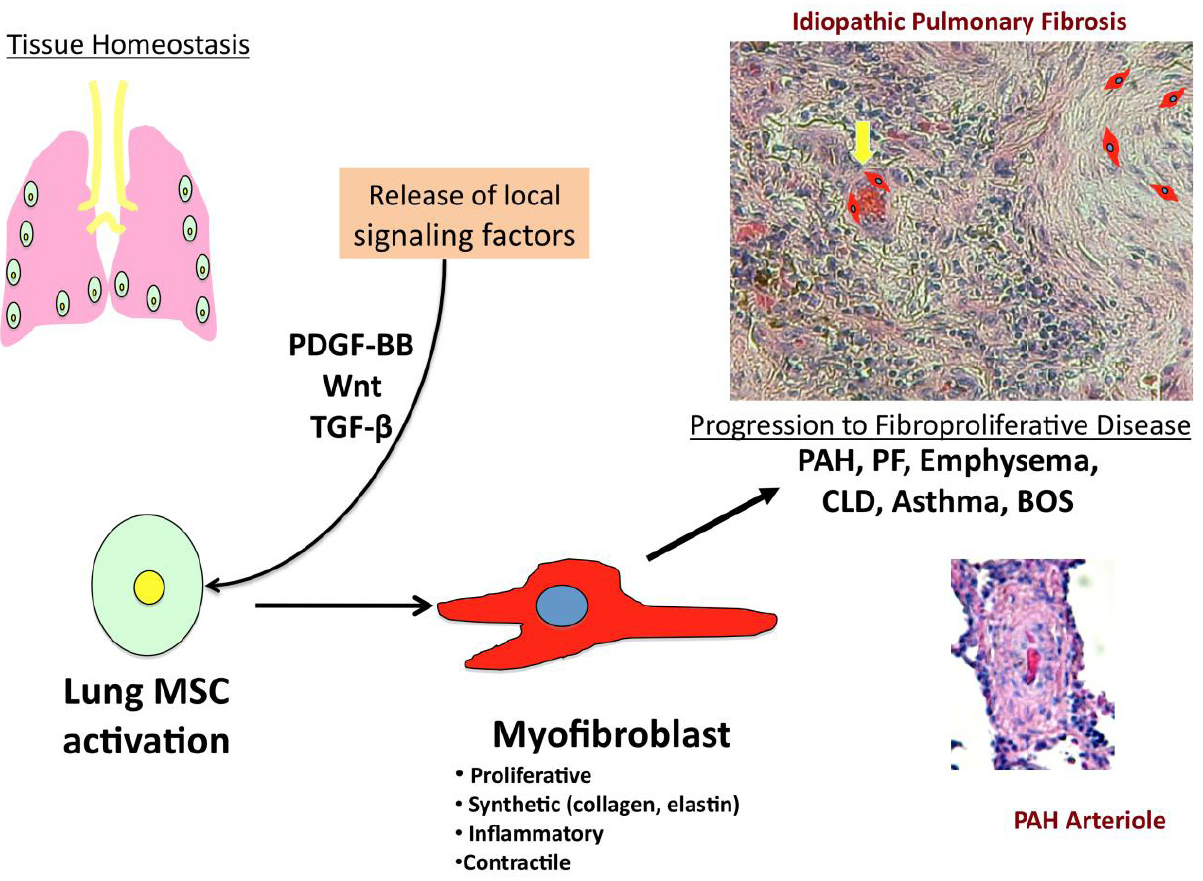
Figure 1. Schematic representation of the microenvironmental influences on resident lung mesenchymal stem cell function during tissue homeostasis and